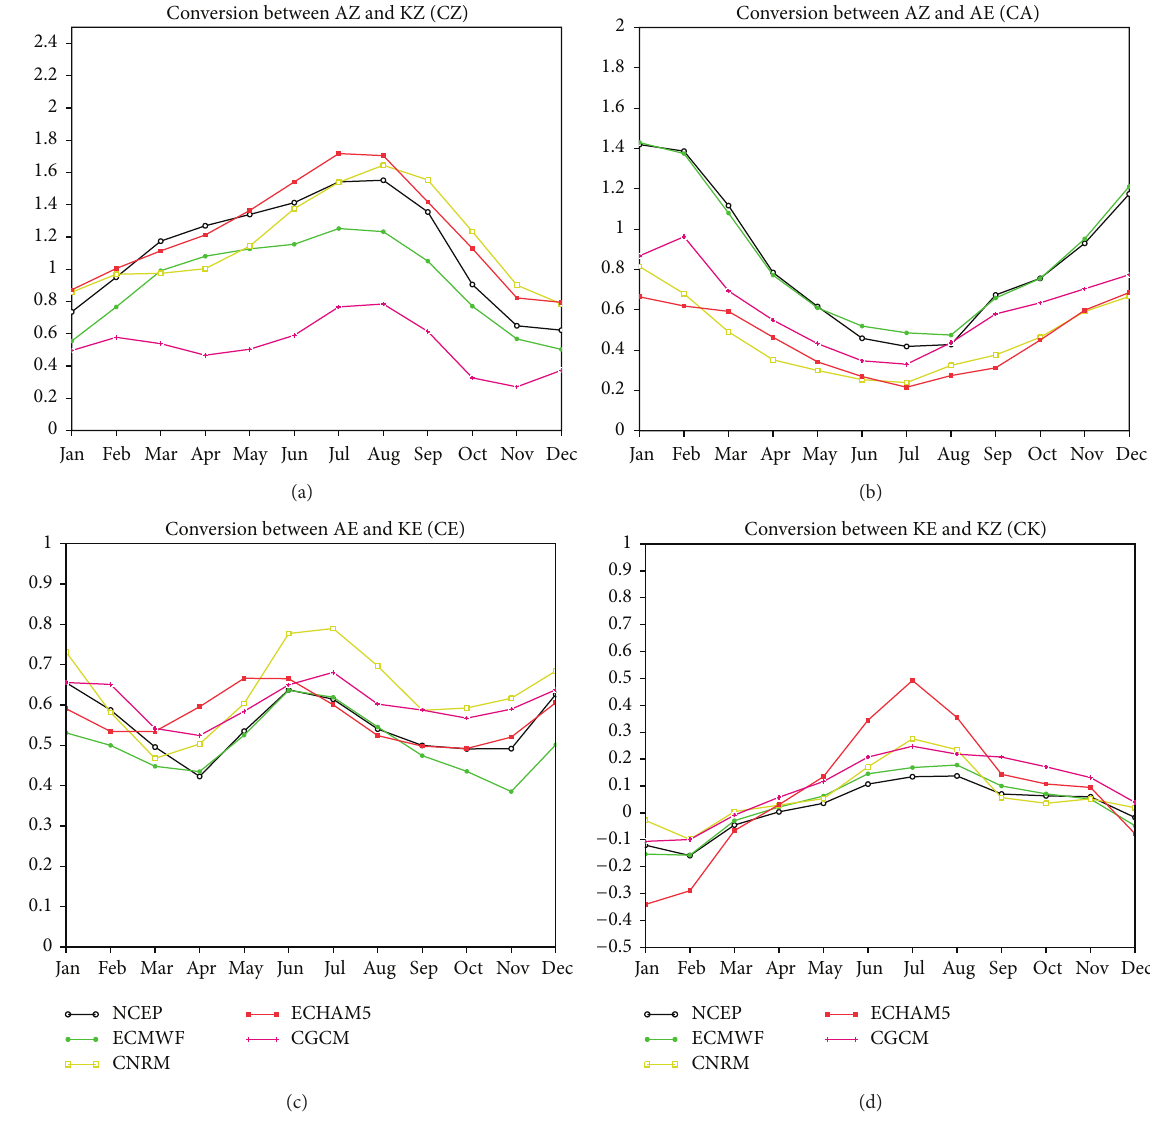
Figure 2: Climatological annual cycle of the conversion between AZ and KZ (a), conversion between AZ and AE (b), conversion between AE and KE (c), and conversion between KE and KZ (d) for the period between 1979 and 1999. Units are Wm −2 .